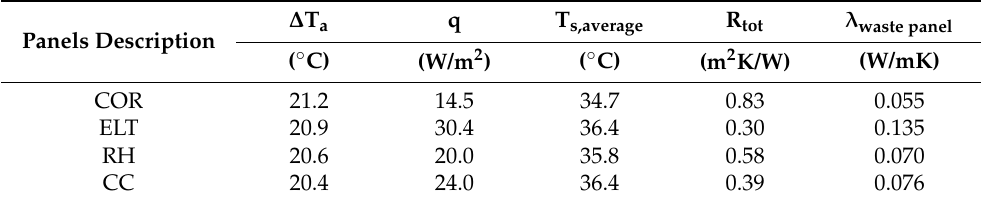
Table 5. Thermal conductivity of the recycled panels with a sole material and related measurement parameters [12,16].